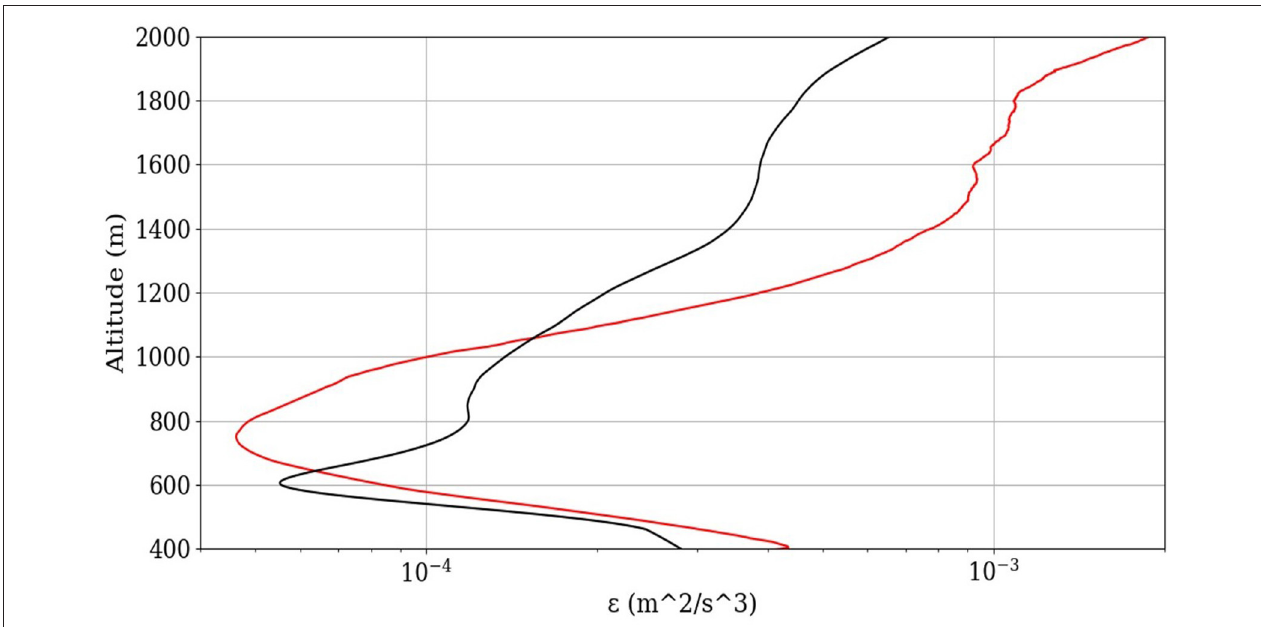
FIGURE 6 | ε ( z ) profile (red) calculated with multifractal theory coupled with lidar-obtained length scales; ε ( z ) profile (black) calculated with Ros˛u -Tatarski method. Length scales profiled on the 28th of May 2017, 20:05.